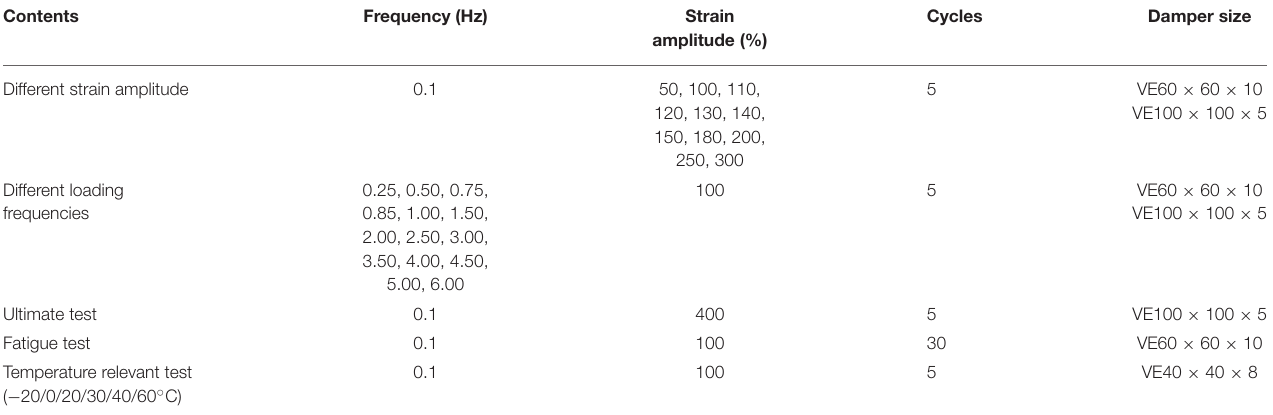
TABLE 1 | The loading scheme of the mechanic performance